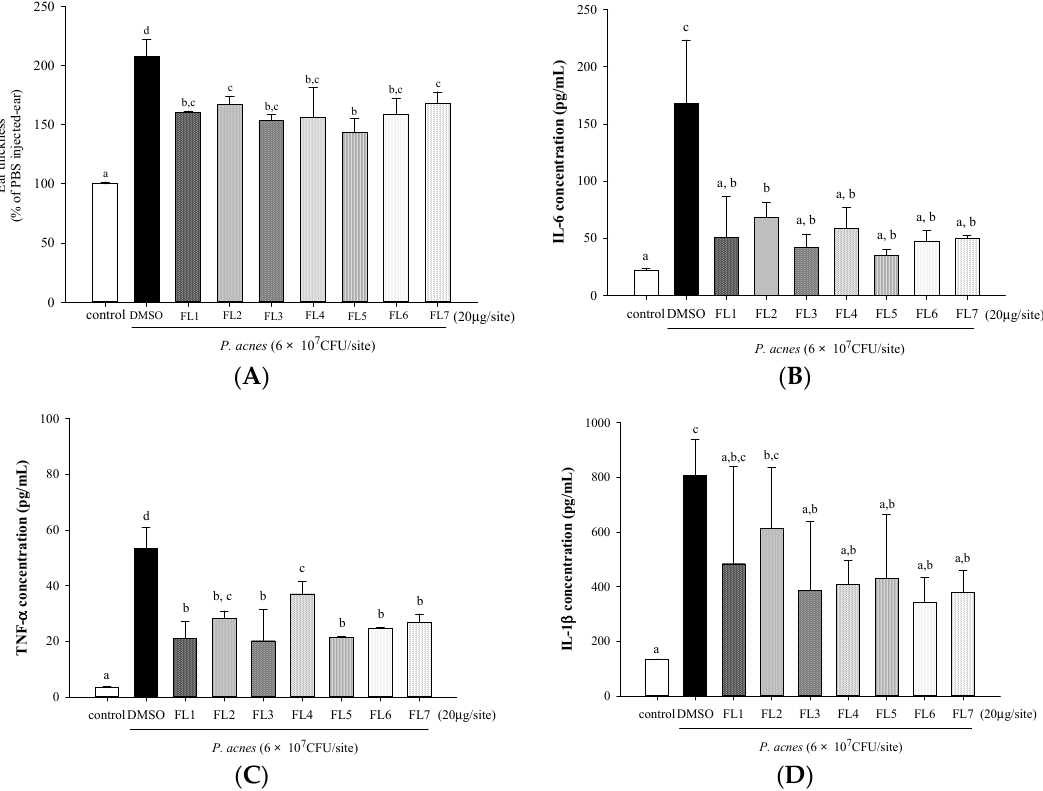
Figure 3. In vivo inhibitory effects of seven flavones isolated from Scutellariae radix on P. acnes -induced skin swelling and pro-inflammatory cytokine levels of mice ears. ICR mice were intradermally injected with PBS (as control), DMSO + P. acnes (as vehicle control), or flavones + P. acnes. Mouse ear thickness ( A ); and IL-6 ( B ); TNF- α ( C ); and IL-1 β ( D ) production in mouse ear homogenates were determined. Values with the same letter are not significantly different as determined by Duncan’s multiple range tests.